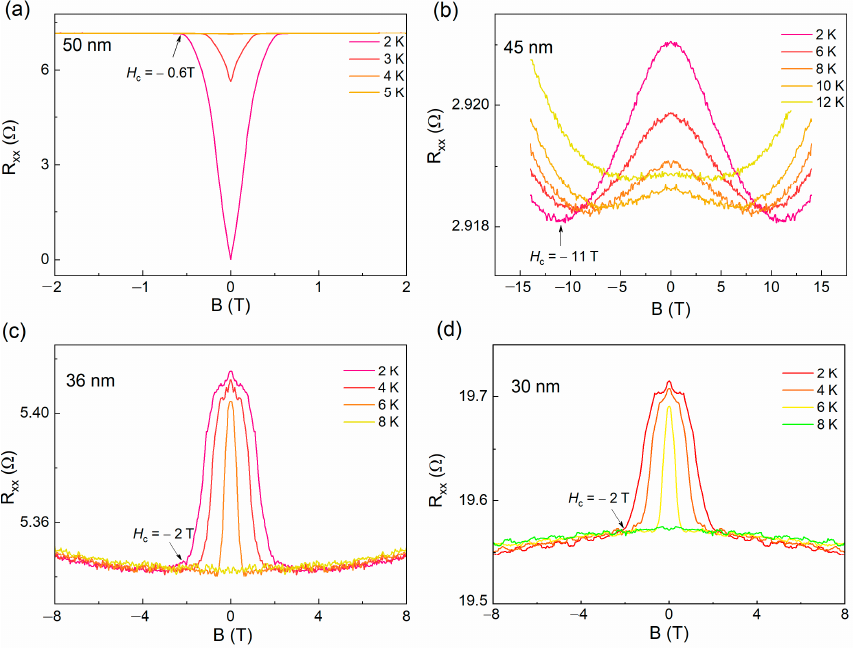
Figure 4. The magnetic dependence of resistance curves at different temperatures in β -PdBi 2 flakes with varying thicknesses of ( a ) 50 nm, ( b ) 45 nm, ( c ) 36 nm and ( d ) 30 nm, respectively.